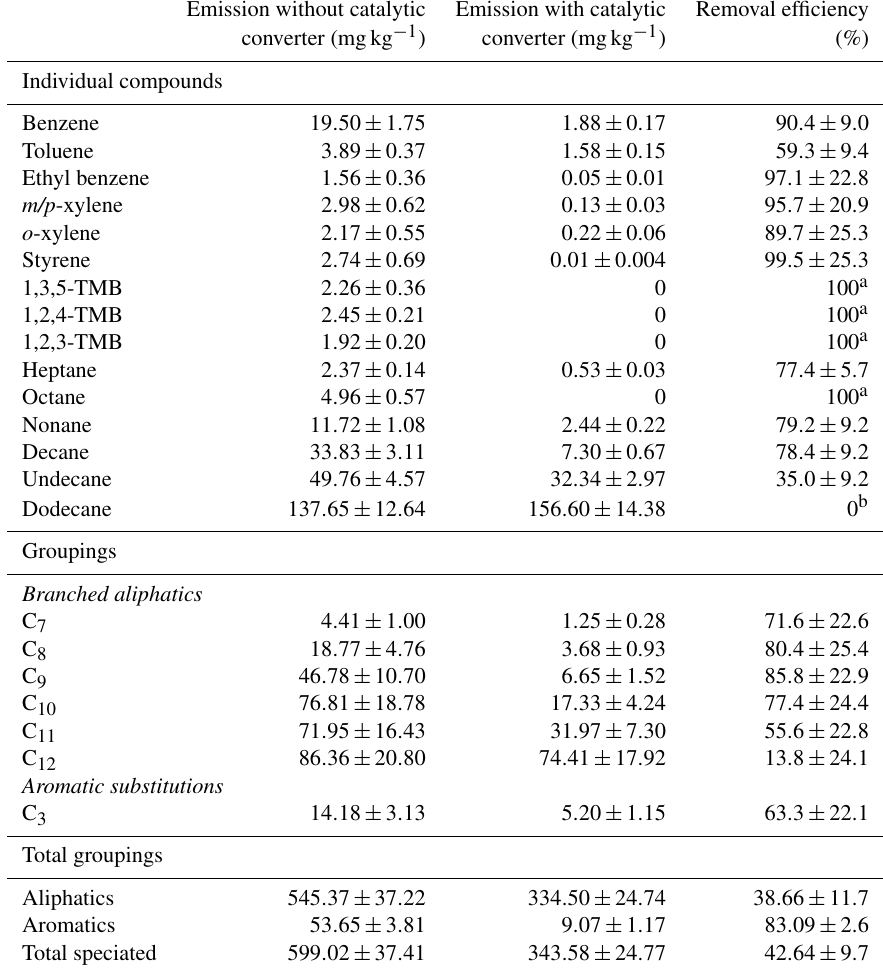
Table 2. Calculated diesel oxidative catalyst (DOC) hydrocarbon removal efficiency for the speciated VOC-IVOCs. Determined from mea- sured emission rates of the speciated VOC-IVOCs in two replicate experiments with (exp. 2, see Table 1) and without (exp. 3) a